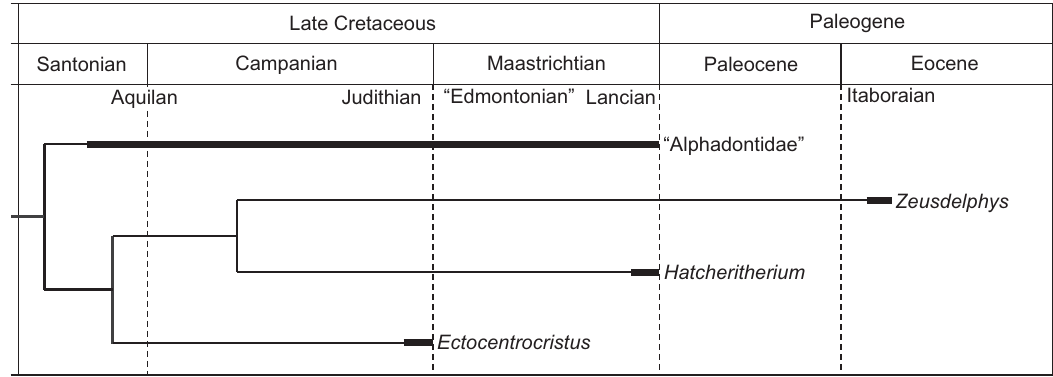
Fig. 5. Temporal and geographical distribution of Hatcheriformes, based on the phylogeny presented in Fig. 2. The wide bars indicate the recorded tem- poral range of Hatcheriformes taxa. NALMAs: Aquilan, Judithian, “Edmontonian”, and Lancian; SALMA: